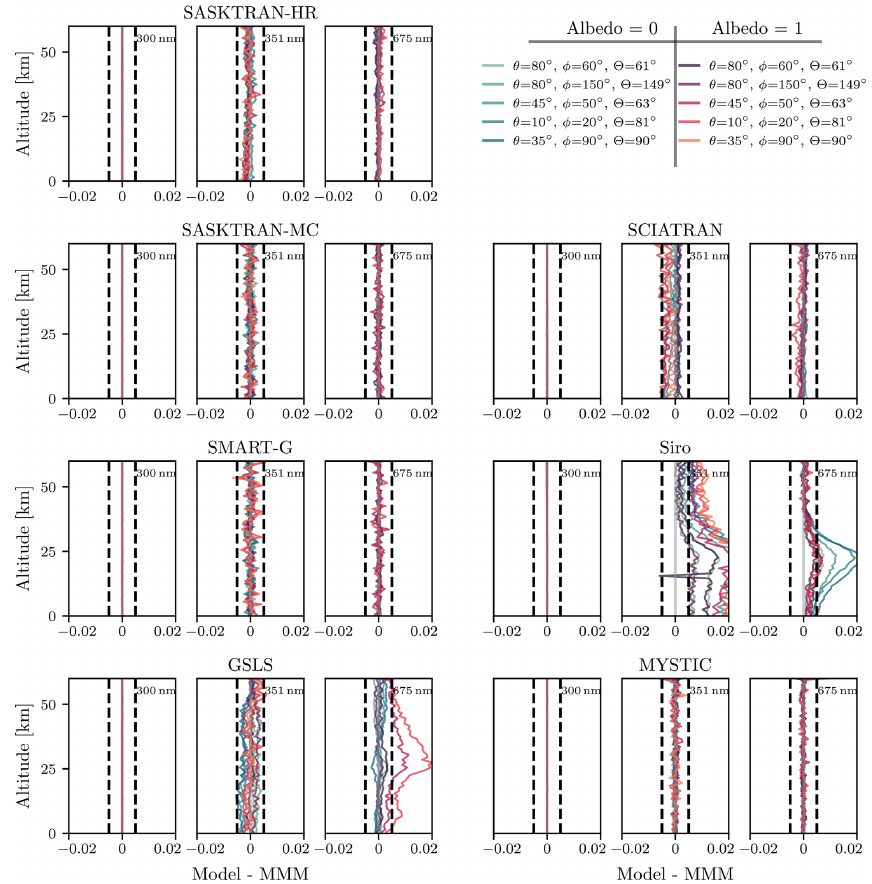
Figure 6. Absolute differences in DOLP relative to the MMM (MYSTIC, SASKTRAN-MC, and SMART-G) for each RTM at a variety of wavelengths and solar conditions. The atmospheric optical properties include Rayleigh scattering, ozone absorption, and stratospheric aerosol Mie scattering. Refraction is disabled. Dashed vertical lines indicate ± 0 . 005